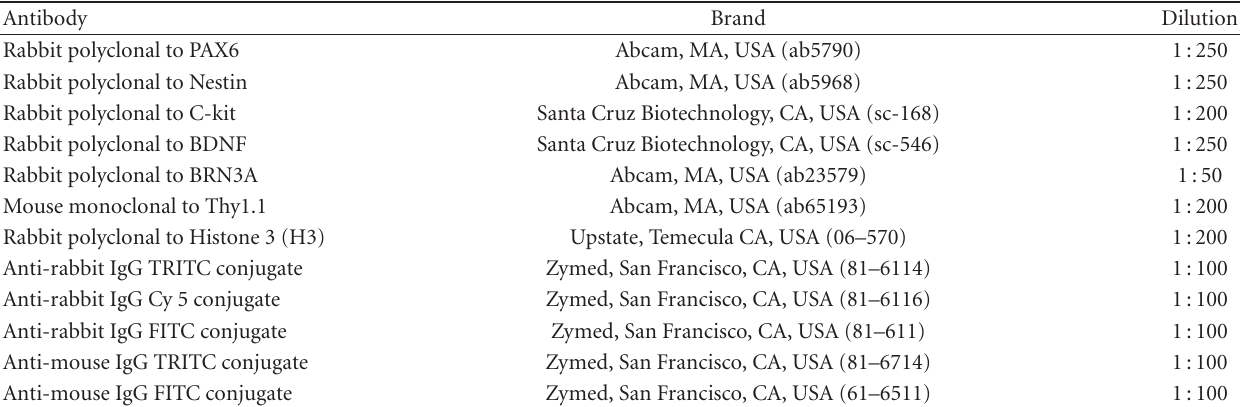
Table 1: Antibodies and